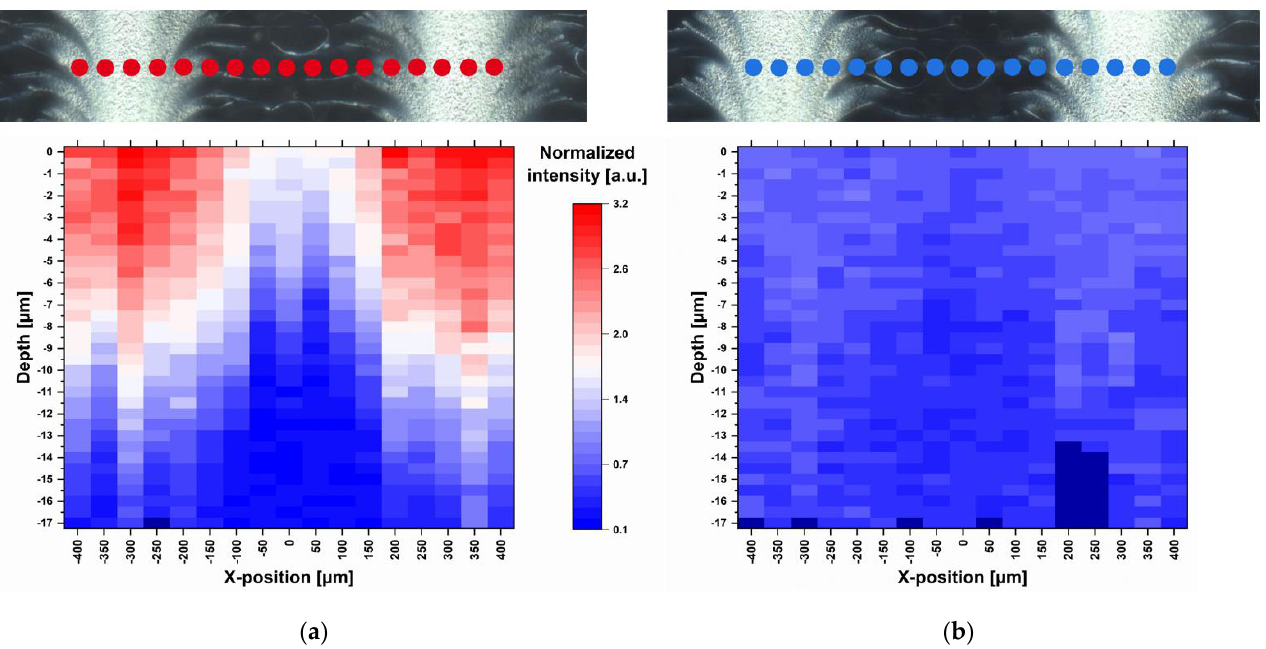
Figure 4. Dark field images and corresponding heatmaps of single-point depth scans (17 positions) at 1615 cm −1 recorded with spatial resolution of 0.5 µm and 10.0 s exposure time ( a ) one day after printing and ( b ) 2.5 months after printing, normalisation related to the HPMC peak at 1370 cm −1 ; red: high intensity, blue: low intensity, dark blue: no data available.